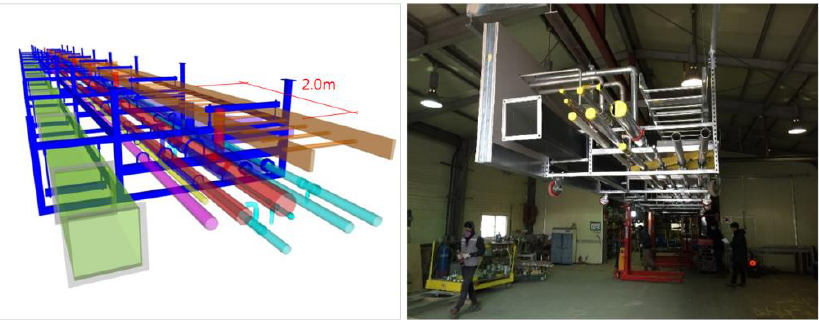
Figure 4. Type D: Frames that can be directly fixed to the concrete (supporting interval: 2 m).